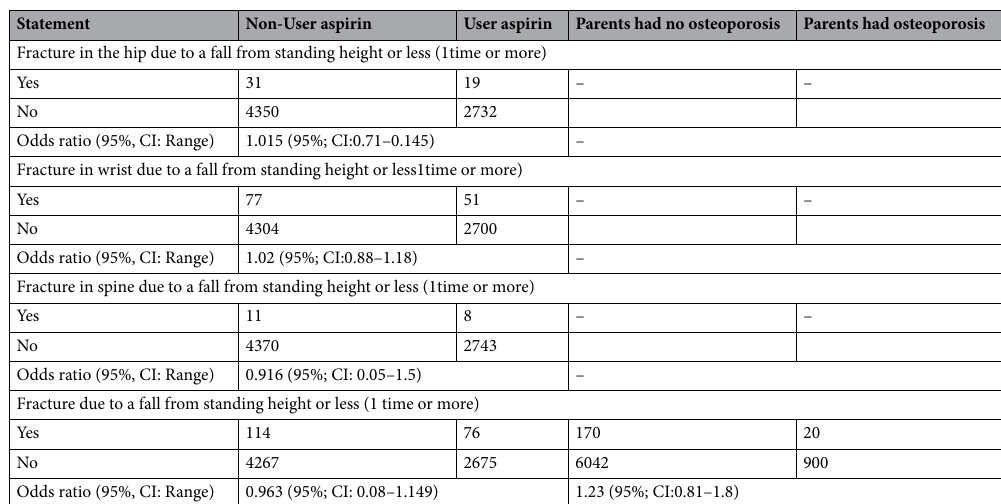
Statement Non-User aspirin User aspirin Parents had no osteoporosis Parents had